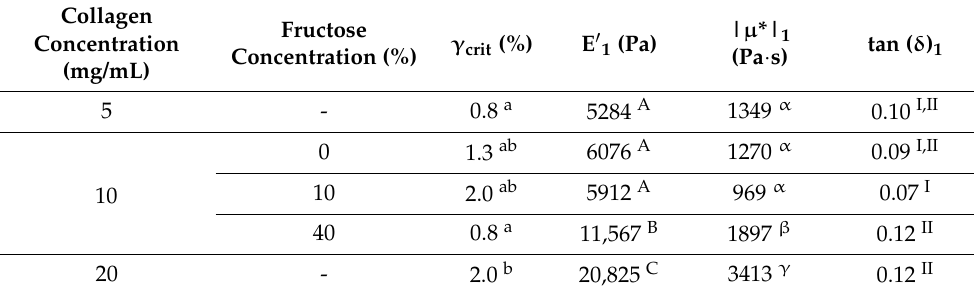
Table 2. Critical strain (y crit ), elastic modulus, complex viscosity, and loss tangent at 1 Hz (E (cid:48) 1 , | µ *| 1 and tan( δ ) 1 , respectively) of 10 mg/mL collagen-based aerogels with different concentration of fructose (0, 10, and 40 wt.%). Different letters as superscripts were included to denote significant differences in the values shown in each column ( p <